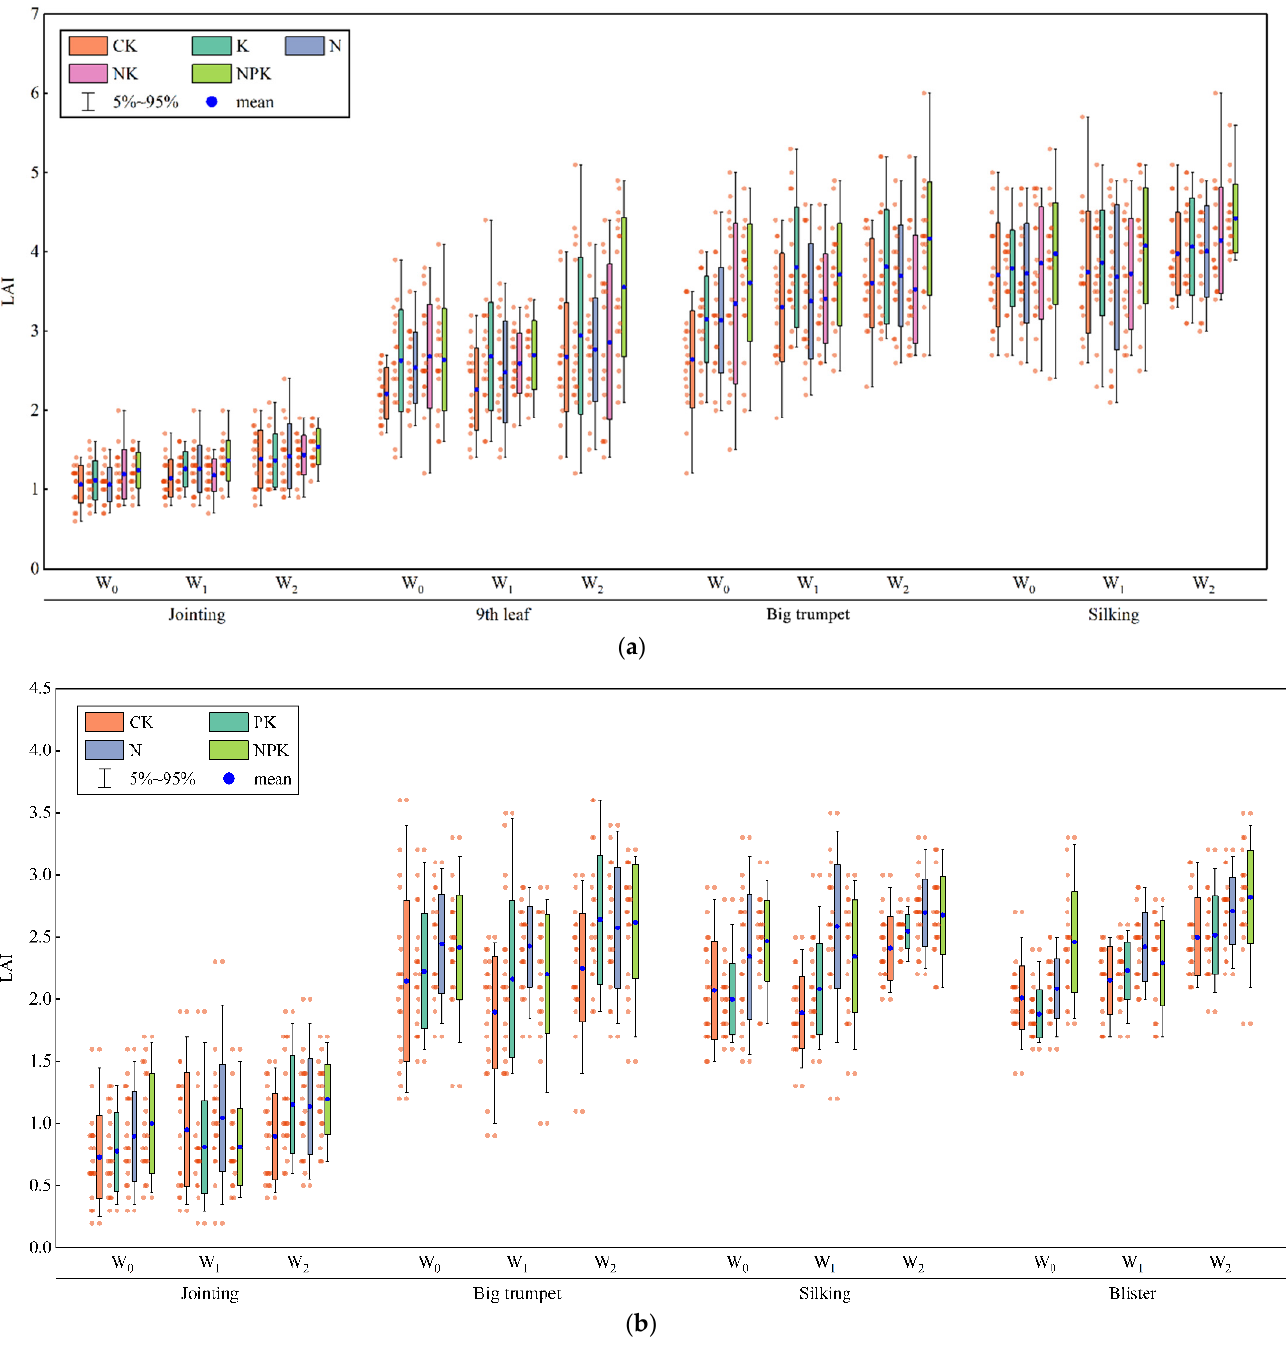
Figure 5. LAI under different water and fertilizer treatments in ( a ) 2020 and ( b ) 2021.